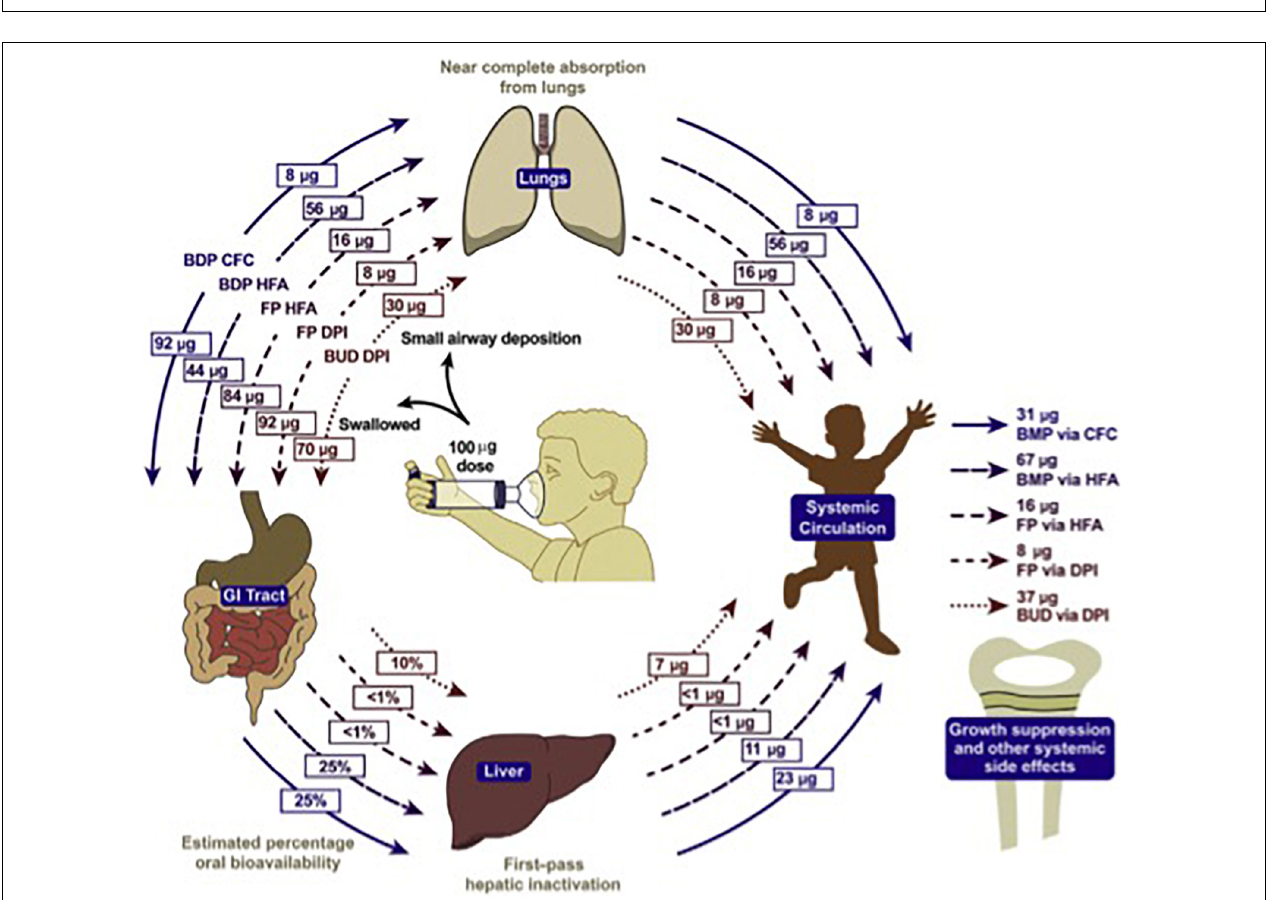
FIGURE 5 | Systemic bioavailability of various ICS preparations